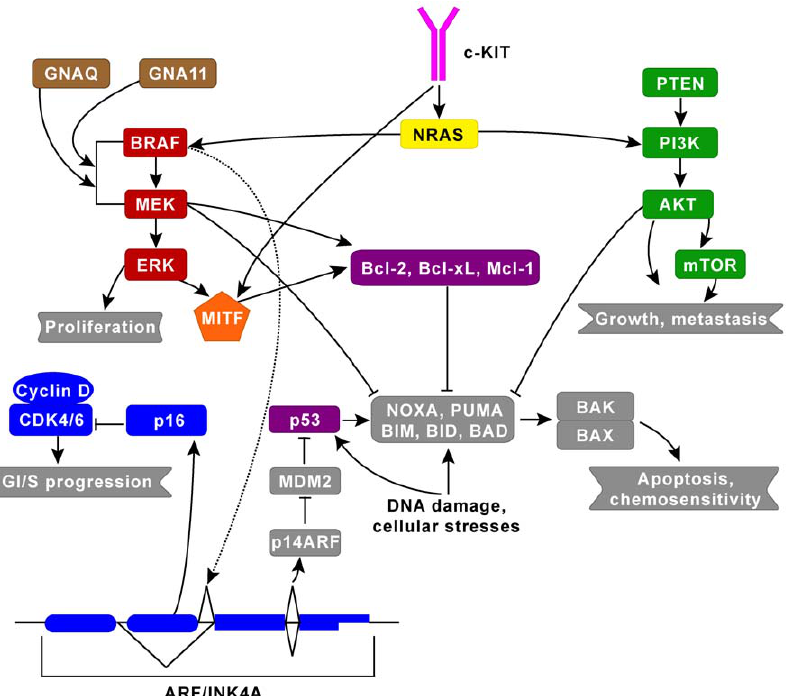
Figure 1. The two major signaling pathways implicated in melanoma are the MAPK pathway (red) and the AKT/PI3K (green) pathway which regulate cell growth, proliferation and cell death. There is a lot of cross-talk between these pathways and their downstream effectors, which we have classified into 8 pathways for simplicity to account for differences in treatment modalities (e.g. signaling through NRAS could affect both MAPK and AKT/PI3K pathways). The additional 6 pathways are: c-KIT (pink), CDK (blue), GNAQ/GNA11 (brown), MITF (orange), NRAS (yellow), and P53/ BCL (purple). The complex relationship among BRAF, ARF/INK4A (via dashed line), p16, and p14ARF connotes an alternative splicing relationship.